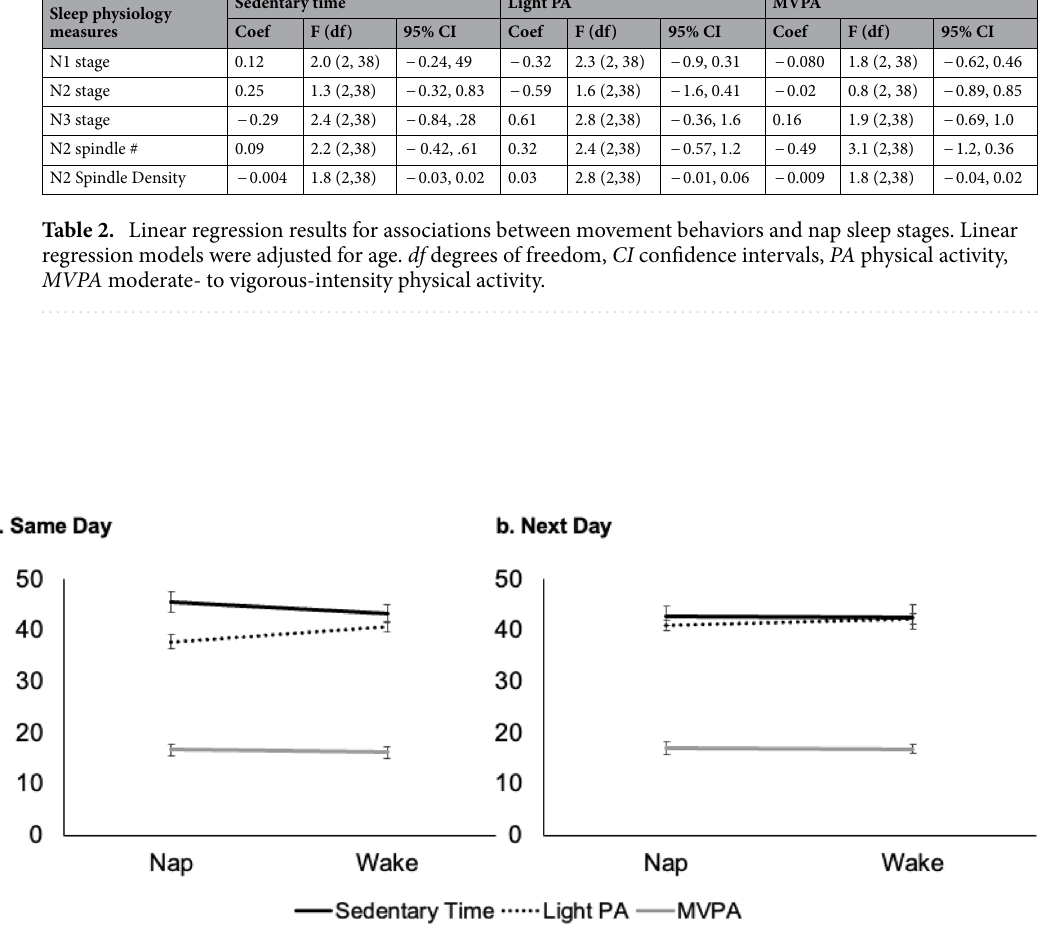
Figure 3. Predicted means and standard errors of wake behaviors by nap group on a) experimental condition days and b) the next day following each experimental day. ( Light PA light intensity physical activity, MVPA moderate- to vigorous-intensity physical